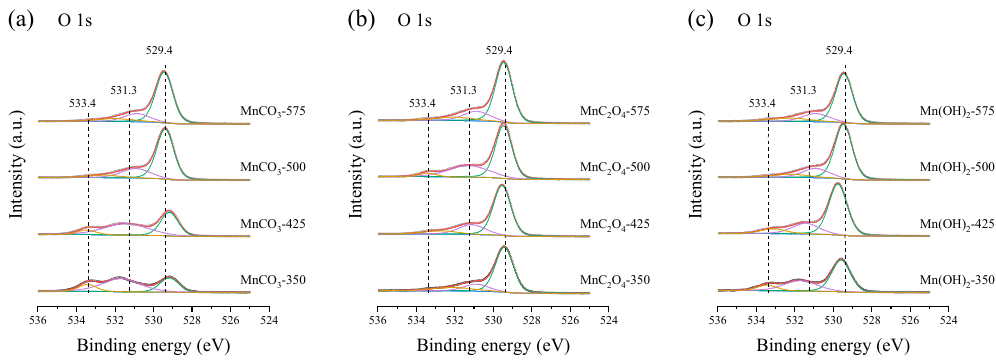
Figure 6. XPS spectra of O 1s for the manganese oxide catalysts obtained by calcining ( a ) MnCO 3 , ( b ) MnC 2 O 4 and ( c ) Mn(OH) 2 .